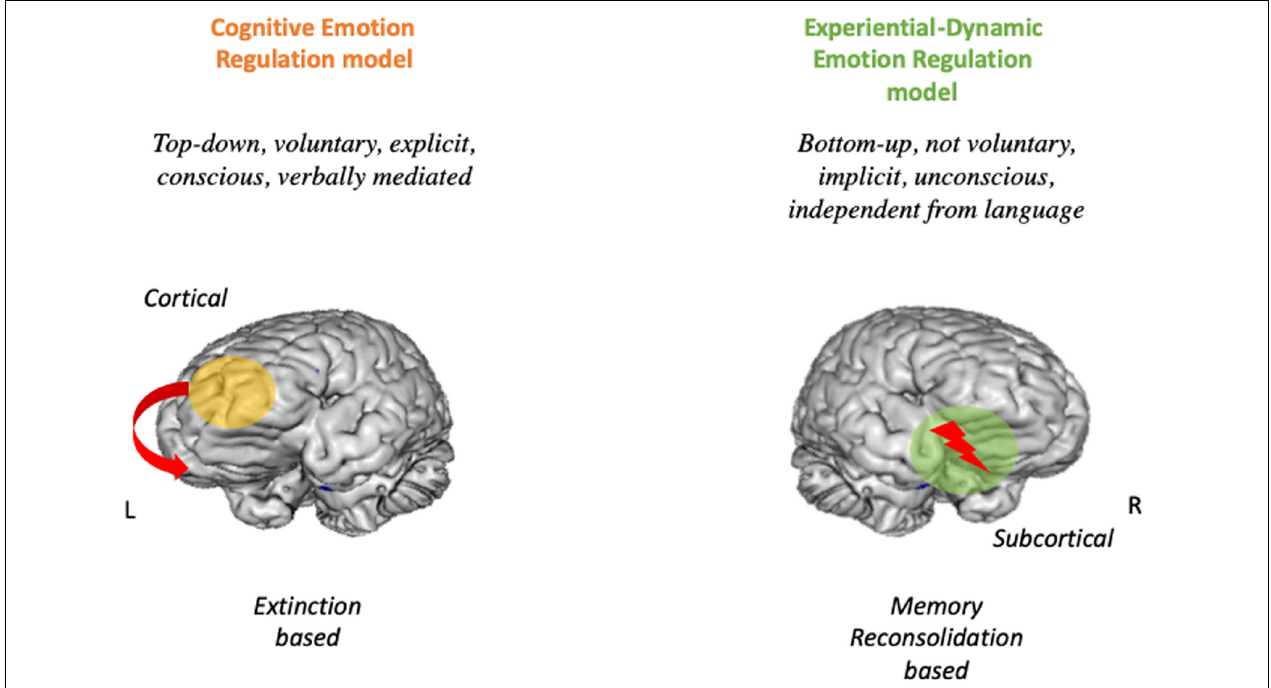
FIGURE 1 | The dual route model of emotion regulation. On the Left the Cogntive emotion regulation route. ON the Right the Experiential dynamic emotion regulation